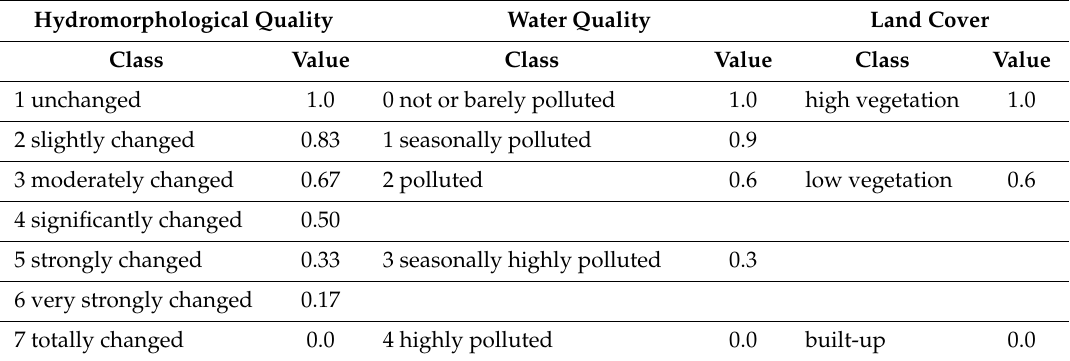
Table 2. Transformation of classes in normalized